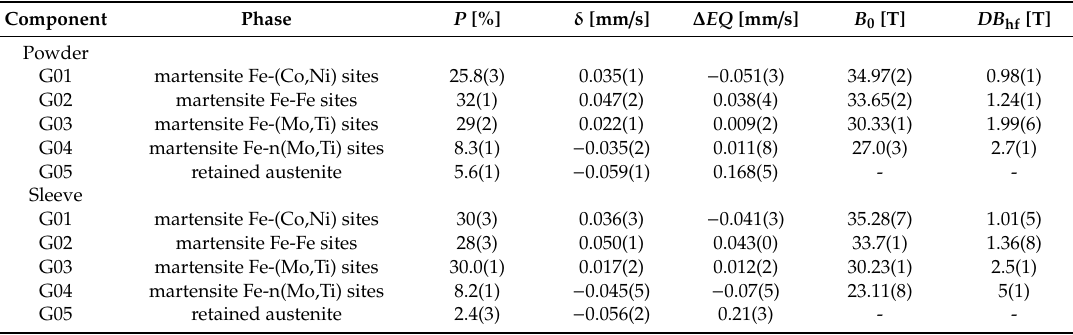
Table 4. Contributions and hyperfine parameters of fitted Mössbauer spectra components for initial powder sample and the sleeve (the recognition of martensite-like and austenite-like components according to